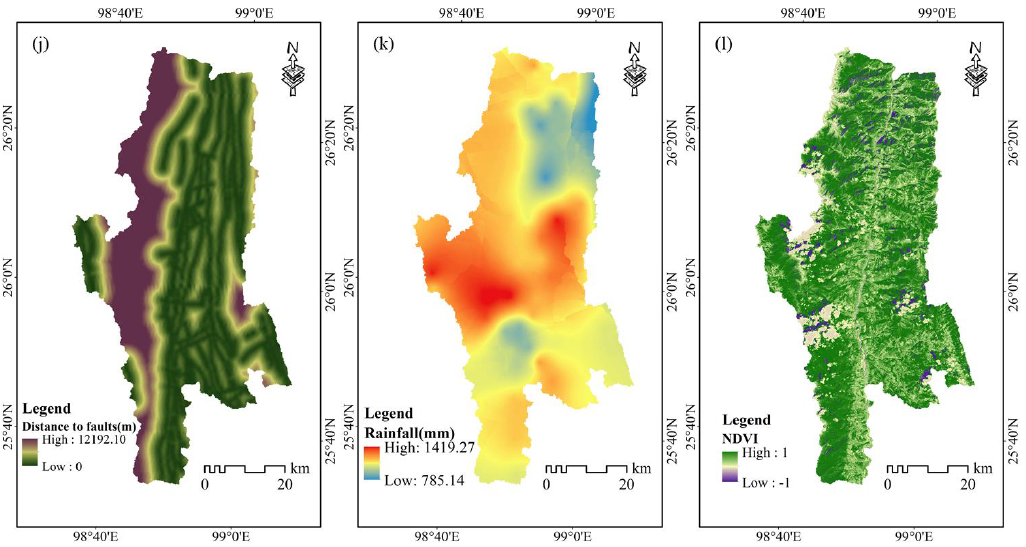
Figure 5. Landslide conditioning factors: ( a ) Elevation, ( b ) Slope angle, ( c ) Slope aspect, ( d ) Profile curvature, ( e ) TWI, ( f ) ERG, ( g ) Land use, ( h ) Distance to roads, ( i ) Distance to rivers, ( j ) Distance to faults, ( k ) Annual rainfall, ( l ) NDVI.